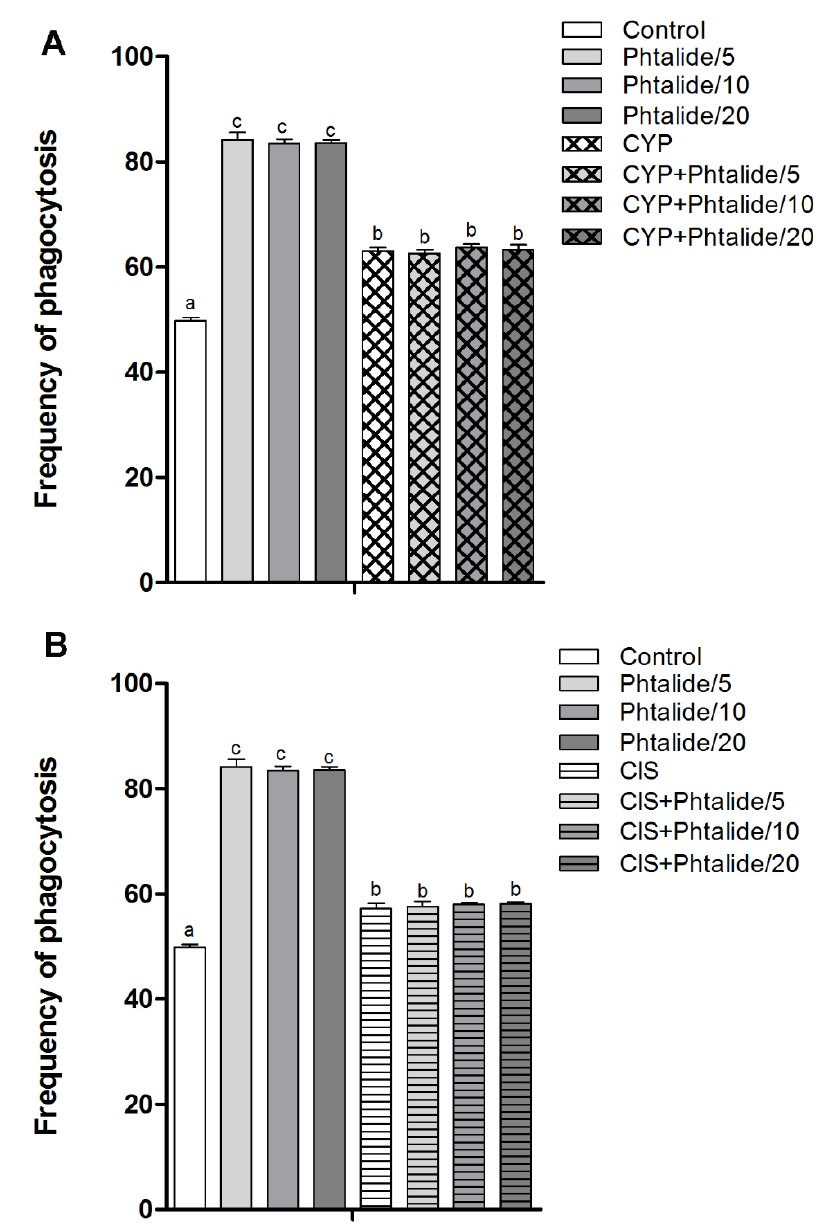
Figure 4. Frequency of splenic phagocytosis. ( A ) Splenic phagocytosis in groups treated with 1 and 1 associated with cyclophosphamide; ( B ) splenic phagocytosis in groups treated with 1 and 1 associated with cisplatin. Legend: g: Gram; CYP: Cyclophosphamide; CIS: Cisplatin; 1 : 3-heptylidene- 4,6-dimethoxy-3 H -isobenzofuran-1-one; 1 /5–5 mg/kg; 1 /10–10 mg/kg; 1 /20–20 mg/kg. Results